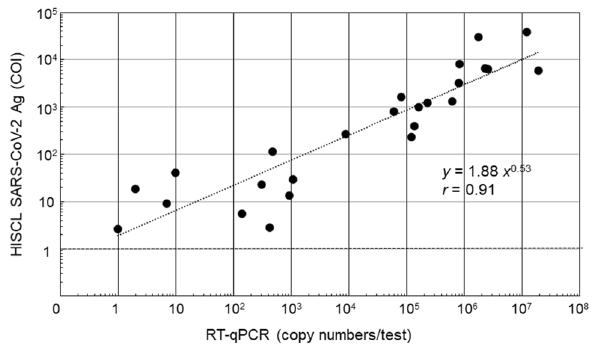
Figure 4. A scatter plot of HISCL SARS-CoV-2 Antigen (COI) and copy numbers measured by RT-qPCR tests. Data are plotted as logarithmic scales and the plots were fitted with a power approximation.